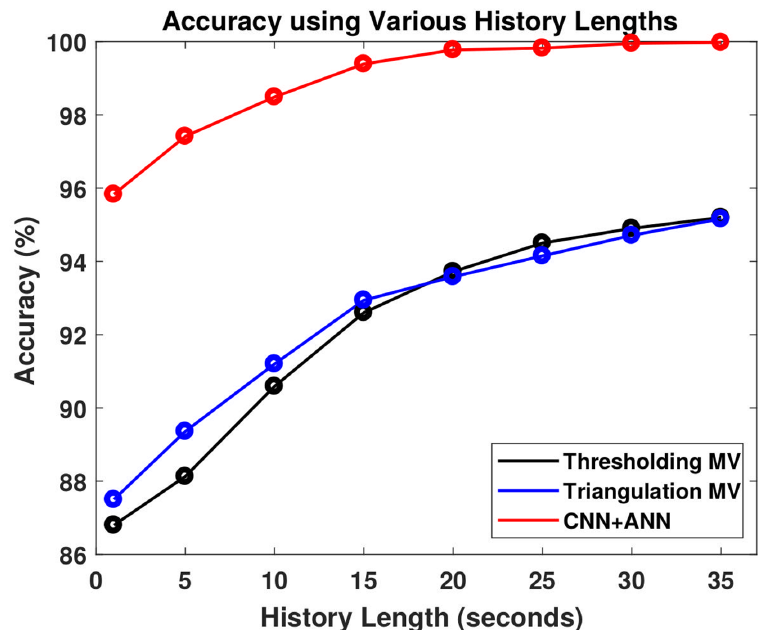
Fig 7. Classification accuracy with history length. The accuracy as a function of the history length (seconds) is displayed for the three classification methods: Thresholding with majority voting (Thresholding MV), Triangulation with majority voting (Triangulation MV), and the CNN+ANN